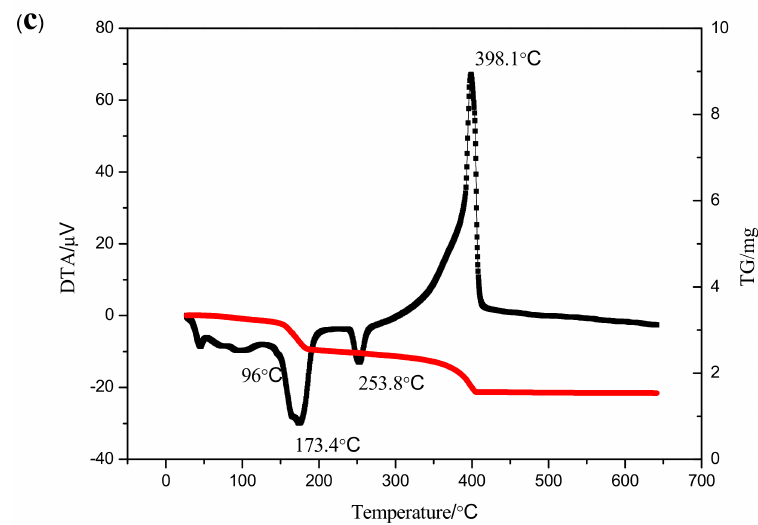
Figure 7. Differential thermal analysis–thermogravimetry (DTA-TG) curves for ( a ) pure SnO 2 ; ( b ) SnO 2 -ZnO; and ( c ) B/Ag/F tridoped SnO 2 -ZnO powders within the range 30–650 ◦